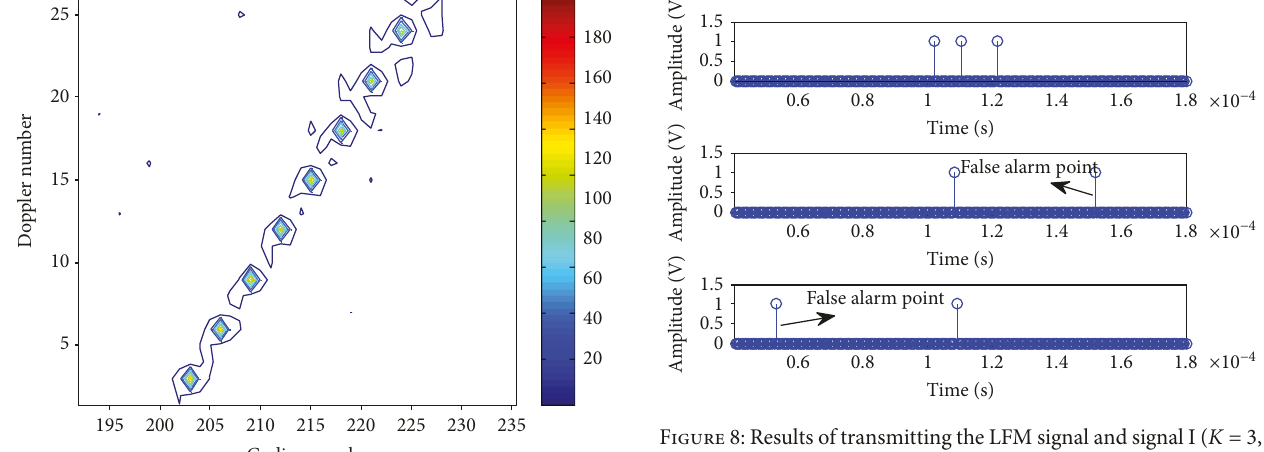
= 3 ) after CFAR (square law 2